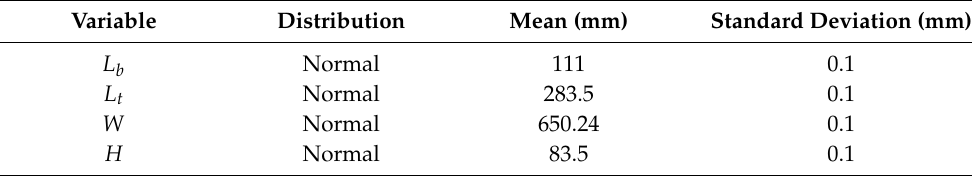
Figure 13. Schematic diagram of steering mechanism. Table 3. Distributions of random variables of size.